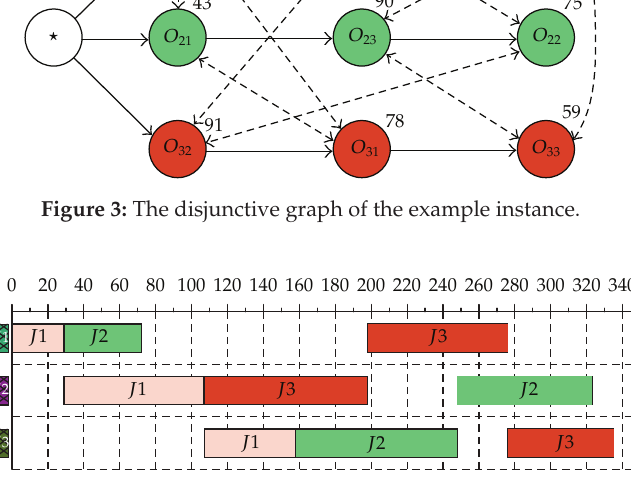
Figure 4: The Gantt chart for the initial